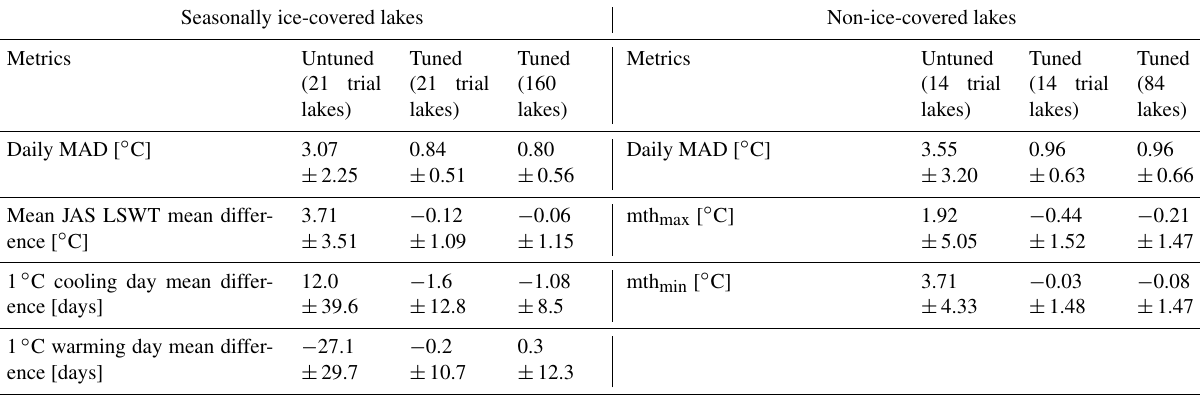
Table 5. Summary of the untuned and tuned metrics for the trial lakes and the tuned metrics for all lakes (metrics are explained in Table 4). The results, presented for seasonally ice-covered and non-ice-covered lakes in each instance, show the mean between the modelled and observed values, across lakes with the spread of differences defined as 2 σ . For tuned lakes, wind speed scaling u 3 was applied to all seasonally ice-covered and to non-ice-covered lakes > 35 ◦ N/S and no scaling ( u 1) to non-ice-covered lakes < 35 ◦ N/S. Units are given in square brackets.